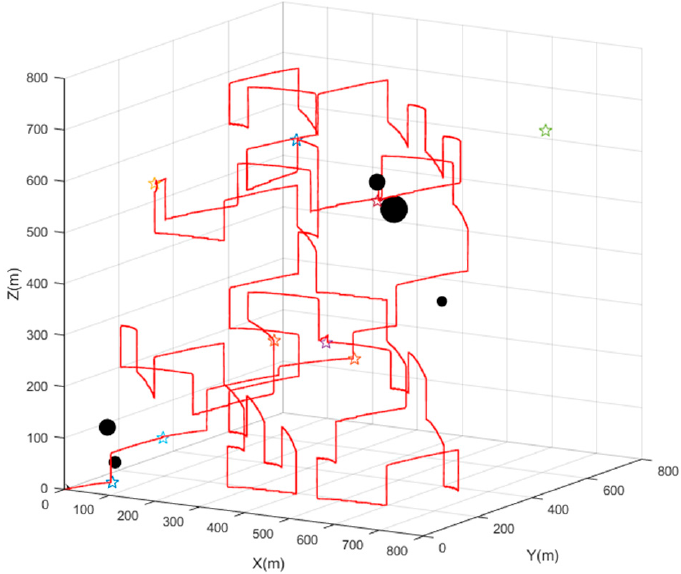
Figure 18. Target search trajectory (at coordinate (609,155,611)) without attraction source set. For experiment one and experiment two, the number of steps used for each target is shown in Table 5. According to the experimental data, it can be seen that after setting the attraction source, the AUV searches for the target in the corner with less cost, and completes the unknown target search task with higher efficiency. Table 5. Comparison of steps taken to find the target.